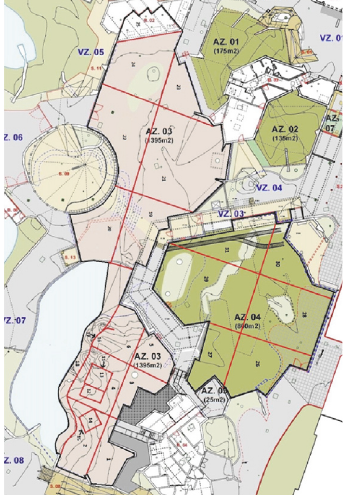
Figure 12: Enclosure map of London Zoo.